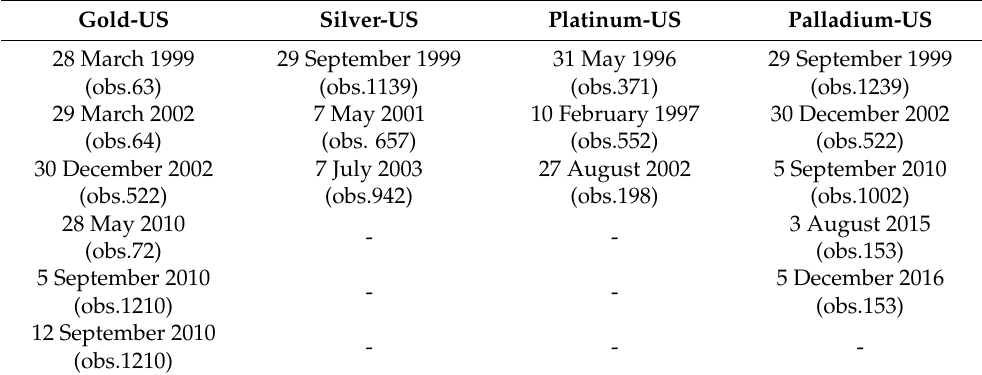
Table A5. GARCH (1,1) Residuals Break Points for Four Precious Metal Pair with US Dow